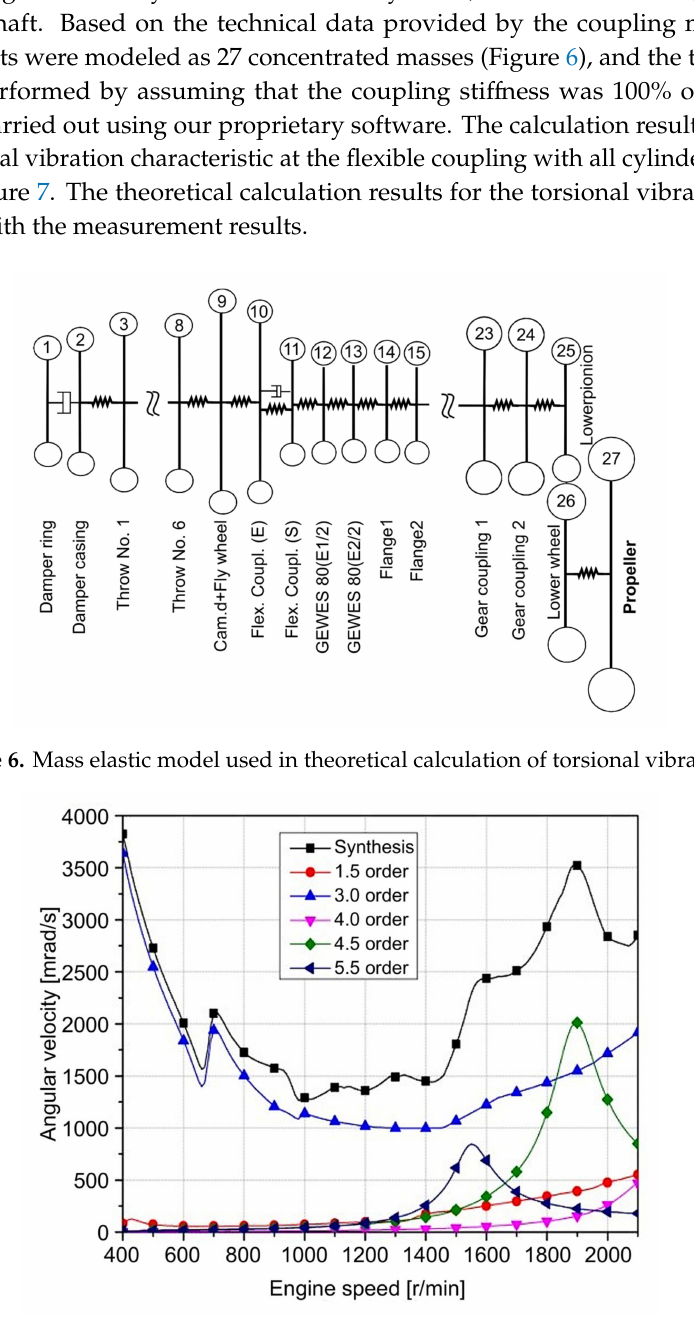
Figure 7. Calculated angular velocity on engine side of flexible coupling with all cylinders operating under normal firing